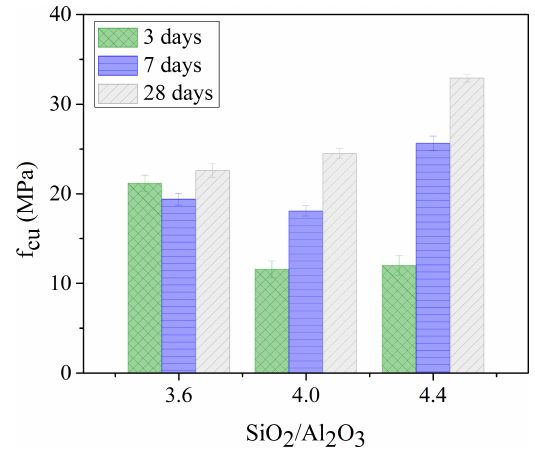
Figure 5: Effect of S/A molar ratio on setting time S/A molar ratio. By keeping the consistency of samples al- most the same, the increase in S/A molar ratio resulted in an increase of the initial and final setting time. However, more increase up to 4.4 caused a relative decrease. The high value of S/A molar ratio in the mixture led to silica- silica reaction, which is relatively slow compared to silica- aluminium reaction, this extended the time of hardening. Regardless the effect of S/A molar ratio in increasing the setting time, the initial time is still considered not long enough for practical applications.